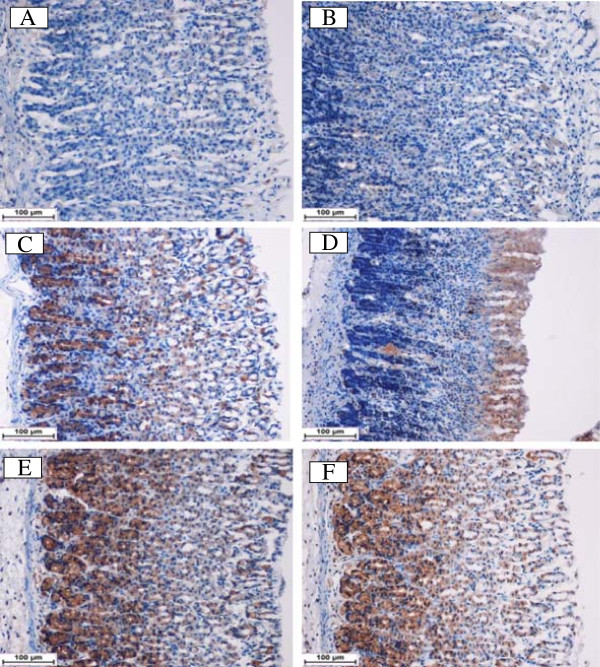
Immunohistochemical analysis of Hsp-70 protein. HSP-70 expression in the gastric tissue of rats submitted to ethanol-induced gastric mucosal lesions at different groups where (A) normal control group, (B) ulcer control group (B), (C) omeprazole group, (D, E, F) the pre-treated groups with DES at doses 5, 10 and 20 mg/kg, respectively. The antigen site appears as a brown color (IHC: 20×).